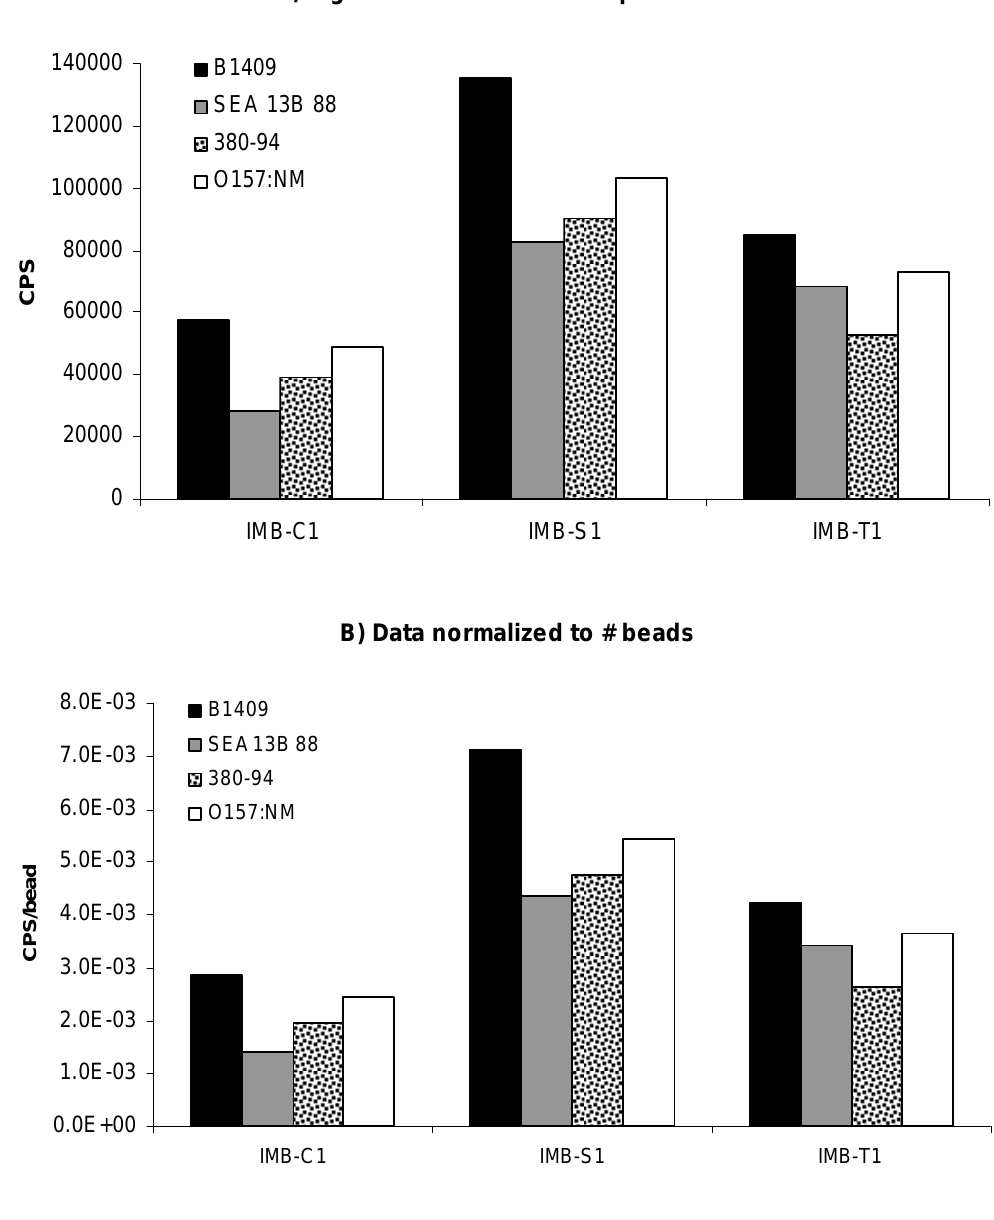
Figure 2. Response obtained using 1  m IMB in the capture of 1×10 7 cells/mL of E. coli O157:H7 and E. coli O157:NM from suspension. A) shows the data obtained in counts per second (CPS) while B) shows the results normalized to the number of beads used per assay. The average percent error among replicates was